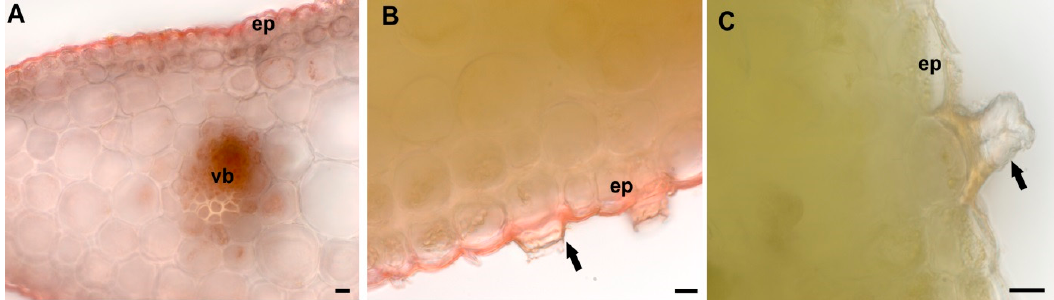
Figure 1. Dithizone staining of Anthyllis leaves for metal localization. ( A , B ) Metallicolous ecotype. Visible red metal-dithizonate complexes in veins (vb), epidermis (ep) and non-glandular trichomes fragments (arrow) of leaves. ( C ) Non-metallicolous ecotype leaf and no red colour is visible. Scale bars = 10 µm.